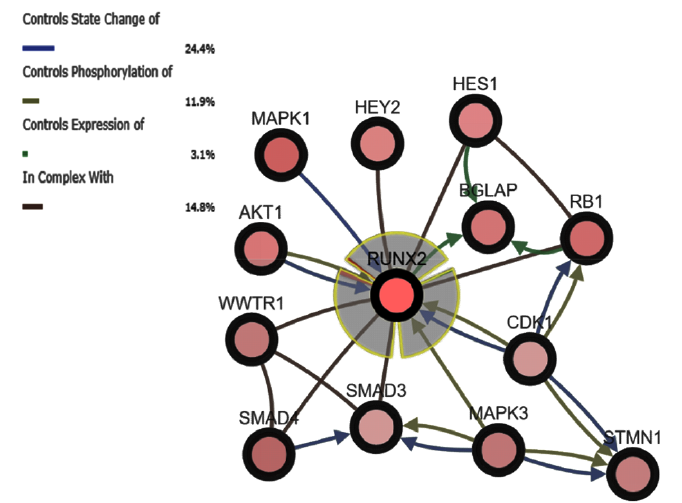
Figure 2. Network Analysis by cBioportal and genomic alterations spectra. The Network depicts RUNX2 and the most relevant interacting genes with the highest genomic alteration in SKCM. The alteration spectrum is reported for each gene. The state of change of RUNX2 is controlled via phosphorylation by AKT1 , CDK1 , and MAPK3 products. RUNX2 can form different types of complex with product of HES1, HEY2, RB1, SMAD3, SMAD4, and WWTR1. Concerning transcriptional modulation, RUNX2 controls BGLAP gene expression. Finally, STMN1 , BGLAP , HEY2 , MAPK1 , SMAD4 , and WWTR1 are neighbor